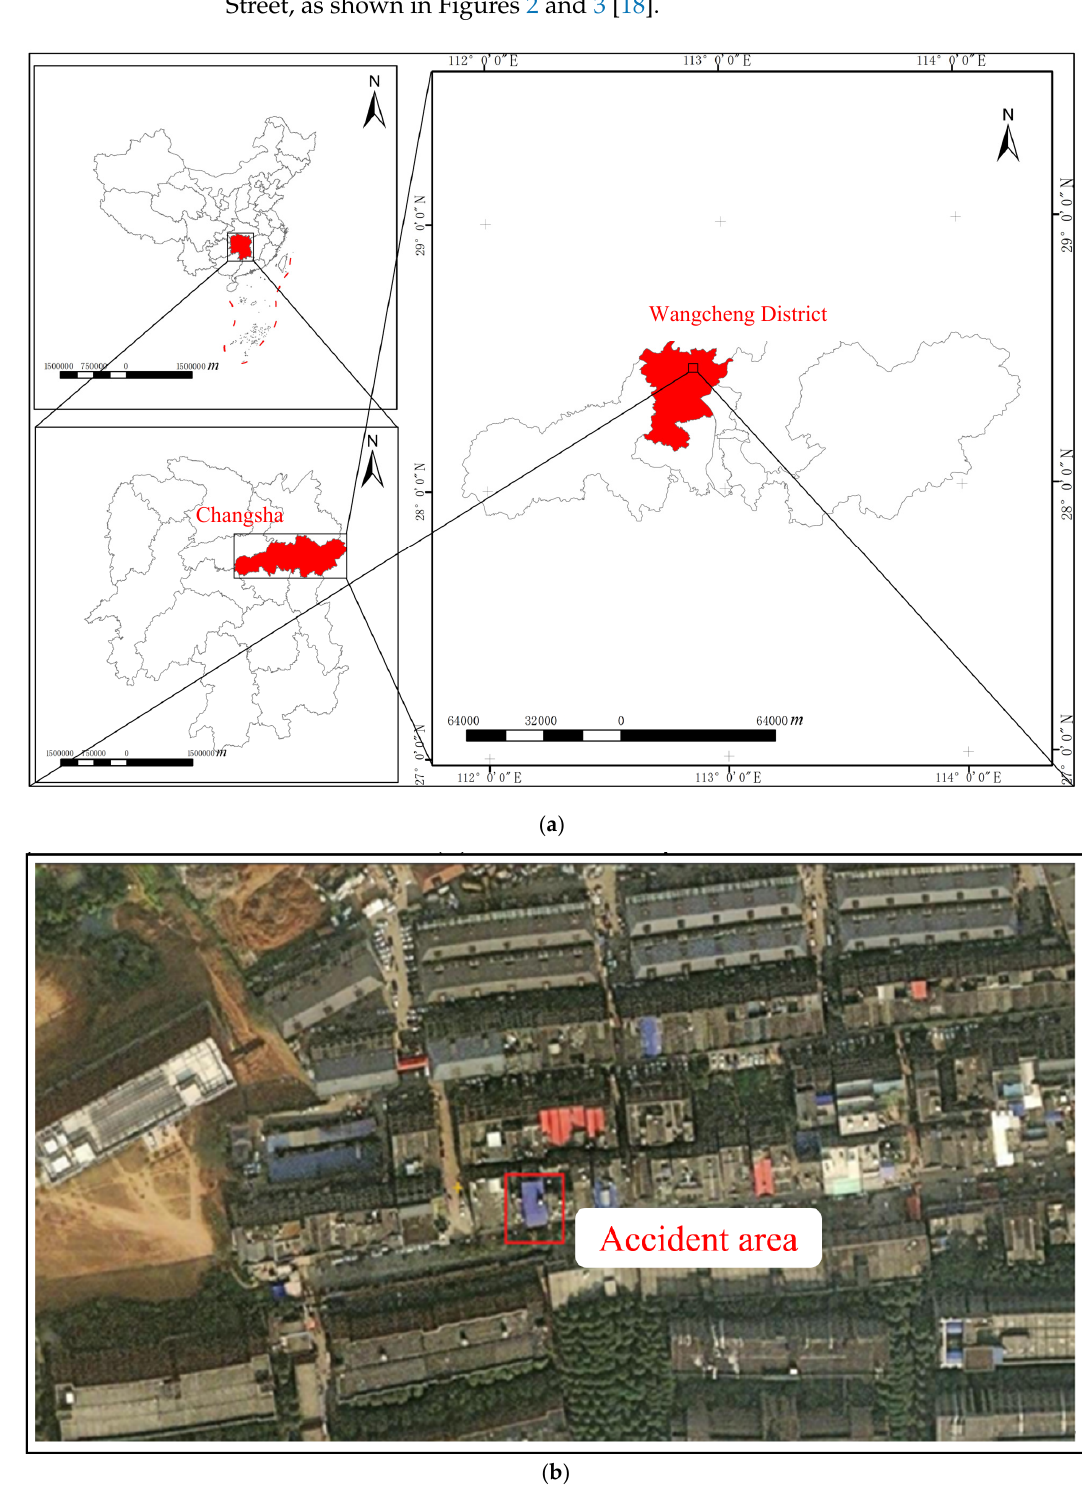
Figure 2. Location of the accident occurrence area: ( a ) Location map and image; ( b ) Accident satellite map.